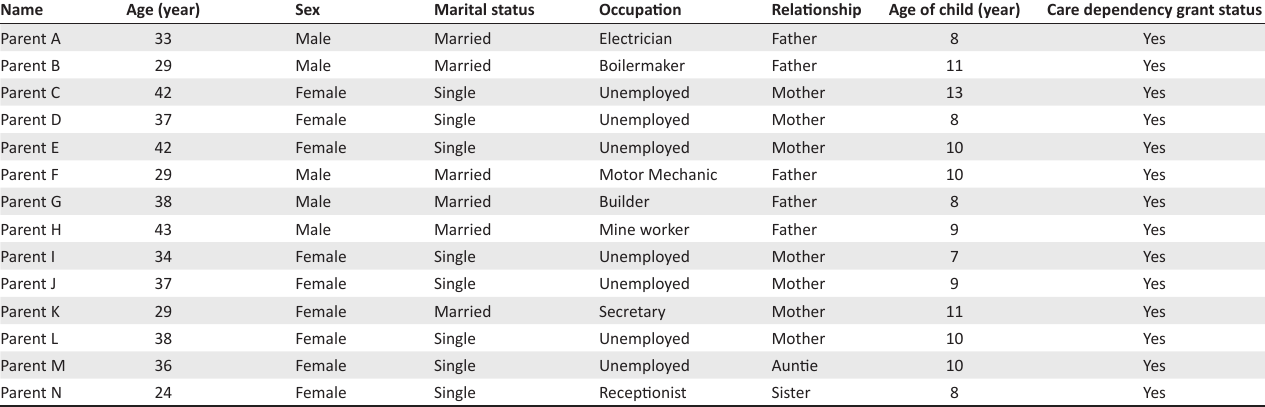
TABLE 1: Biological profile of the study